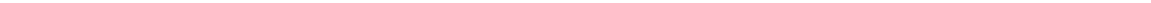
Fig. 5 PrxII binds to tankyrase and preserves its activity in APC-mutant CRC cells. a HT29, SW480, and RKO cells were lysed for immunoprecipitation (IP) with anti-TNKS antibody. The IP complexes and total cell lysates (TCL) were immunoblotted for indicated proteins. Total cell lysates were also loaded in parallel with IP samples to identify the positions of PrxI and PrxII proteins ( Arrowhead ). Asterisk indicates non-speci fi c IgG heavy chain. b HEK293 cells were co-transfected with Flag-TNKS1 and either control (pQ) or Myc-tagged PrxII-encoding vectors and lysed for IP with anti-M2 (Flag) antibody. Asterisks indicate non-speci fi c IgG heavy chains. c An in situ proximity ligation assay shows direct interaction between TNKS and PrxII proteins in the cytosol of SW480 cells. For PrxII-depleted negative control, SW480 cells were transfected with PrxII-1 siRNA. DIC and DAPI-stained images were merged with DuoLink red fl uorescence images (Merge). A representative image from two independent experiments is shown. Scale bar, 20 μ m. d HEK293 cells were co-transfected with truncated mutants of TNKS and Myc-PrxII and lysed for IP with anti-M2 (Flag) antibody. Full-length TNKS1 (1 – 1327) was expressed as a positive control. The amino acid numbers for each truncate mutant are indicated. e PrxII WT and Gly mutants were co-expressed with Flag-TNKS1 in HEK293 cells. The IP complexes were blotted with anti-Myc antibody. f HEK293 cells were co-transfected with Flag-TNKS1 and Myc-PrxII vectors as indicated and then treated with 100 μ M H 2 O 2 for 30 min. The Flag-TNKS1 was immunoprecipitated and then subjected to in vitro PARP assay. Data in the graph are means ± s.d. of the 32 P radioactivity measured in an in vitro assay of PARP activity ( n = 3, * P < 0.01, ** P < 0.005). The hyperoxidation of 2-Cys Prxs were immunoblotted by anti-Prx-SO 2/3 antibody. Asterisks marks a non-speci fi c band. g SW480 cells were transfected with control or PrxII-1 siRNA for 36 h and then infected with retroviruses expressing siRNA-resistant PrxII WT and G116V mutant. SW480 cells were then grown for 10 days, and the colonies were stained with crystal violet and counted. Data in the graph are the average number of colonies ± s.d. ( n = 3, * P < 0.001). Immunoblots (IB) or 32 P-autoradiographs shown are a representative of three independent experiments. Total cell lysates (TCL) were immunoblotted as control for the amount of indicated proteins. The molecular weight markers are labeled in